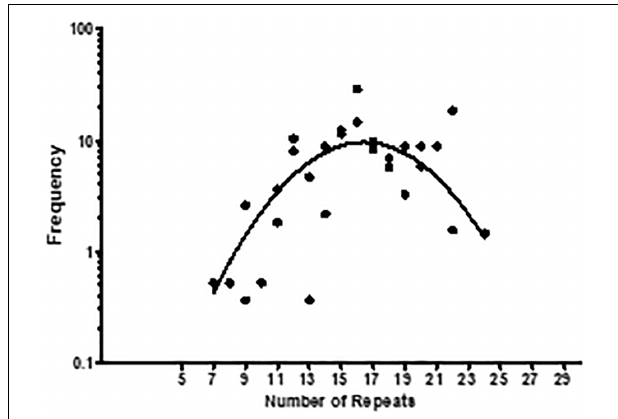
FIGURE 10 | The number of Lcl collagenous GXY repeats influences the clinical incidence of L. pneumophila strains. Clinical strains from Public Health Ontario and the French National Reference Center for Legionella repositories were characterized respect to the number of GXY repeats encoded in their lcl genes. The frequency of the strains was then calculated by summing the number of strains encoding a given lcl gene variant, divided by the total number of strains in both repositories. This was plotted as a function of the number of Lcl GXY repeats. A total of 467 clinical isolates were